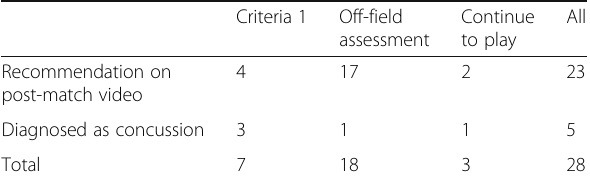
Table 2 Overview of post-season review decisions Criteria 1